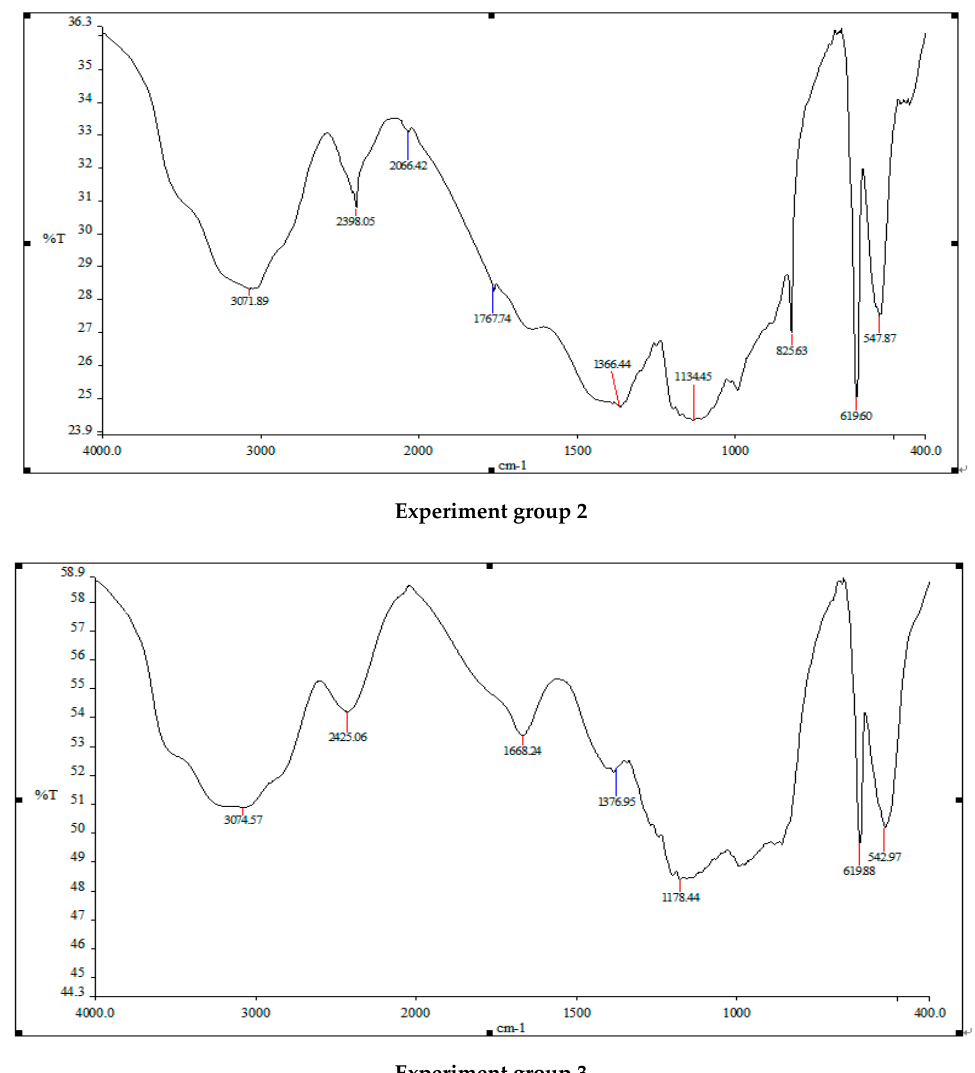
Figure 7. FTIR on three addition methods with Phanerochaete chrysosporium on Turpin FACHB-507.